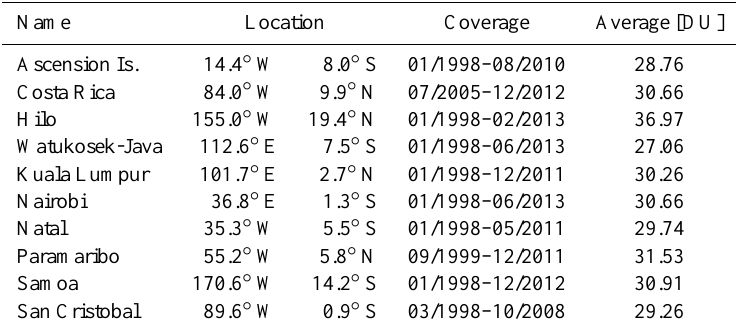
Table 1. Geolocation, temporal coverage and average LS O 3 column of utilised SHADOZ